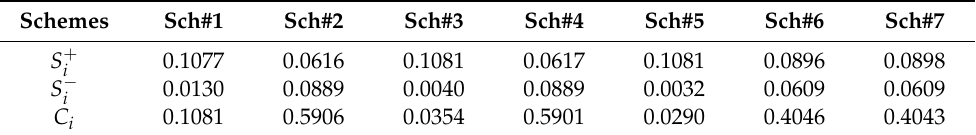
Table 11. Distance to PIS, Distance to NIS and similarity of each feasible scheme in Case